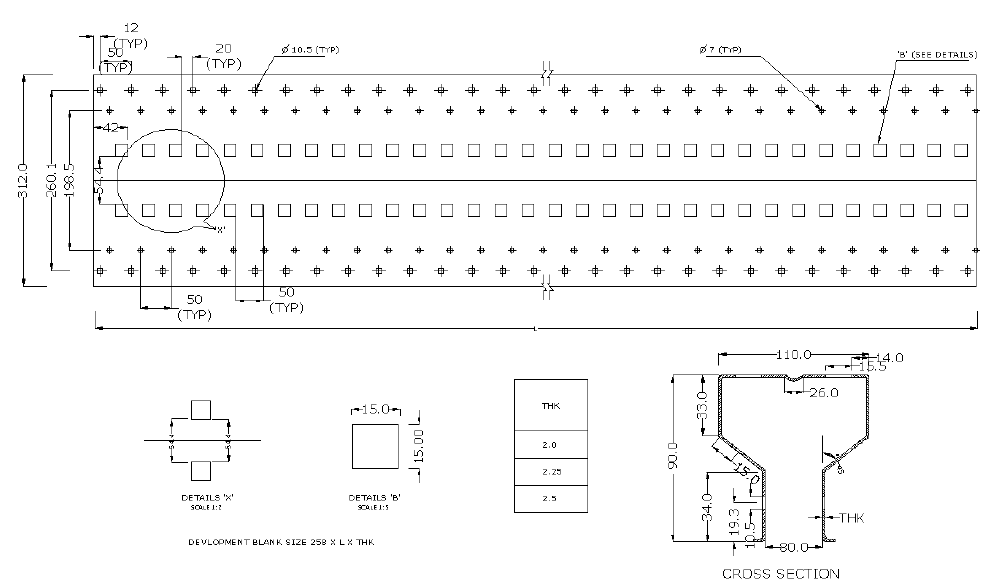
Fig. 2. Heavy weight column section 2.0mm, 2.25mm and 2.5mm thick [12].